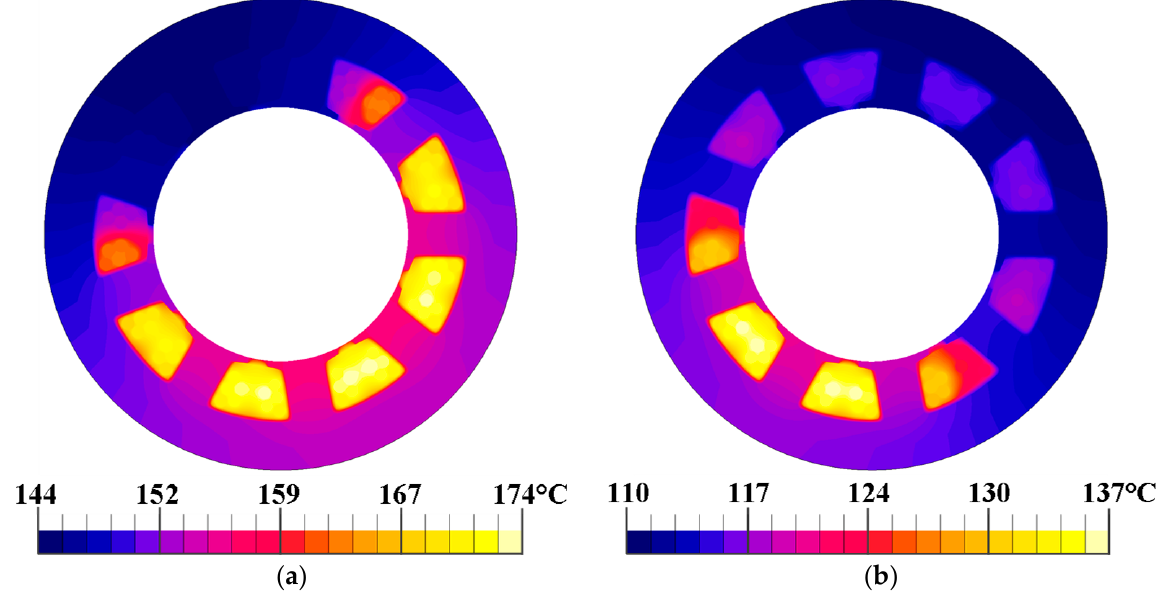
Figure 15. Color shape maps of the temperature distribution on the motor and simulated for the long-time pulse tests: ( a ) configuration A; ( b ) configuration B; ambient temperature of 24.4 °C.